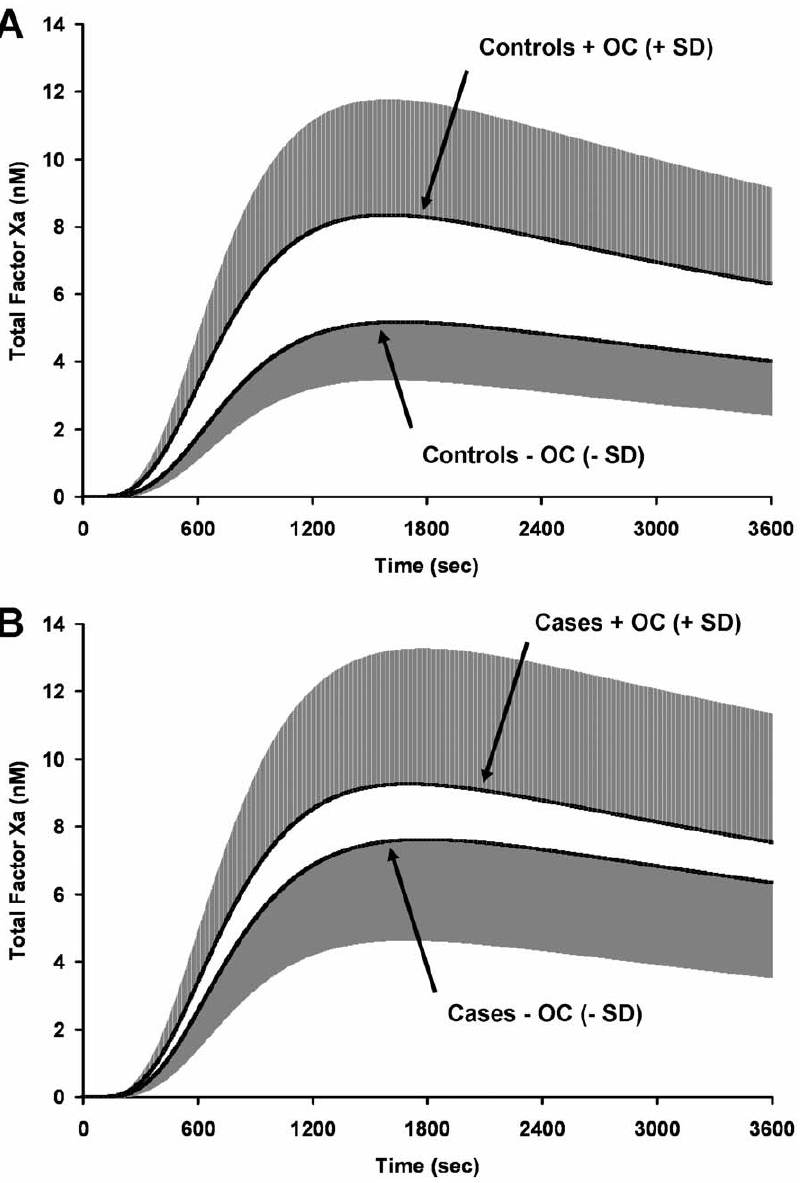
Figure 4. Oral contraceptive use. Premenopausal women aged 15 to 49 were segregated into categories of: Panel A: control women + OC use (n=47) and –OC use (n=90) and Panel B: women with a known DVT + OC use (n=30) and –OC use (n=40). FXa generation was evaluated for these groups. The grey shaded area represents 1 SD.